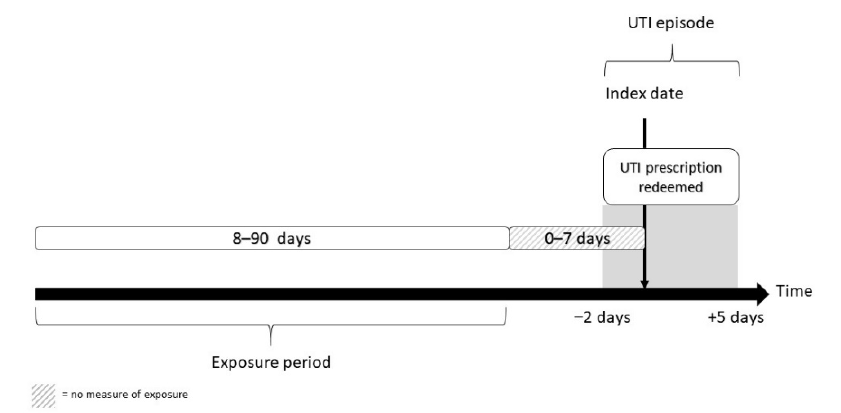
Figure 1. Inclusion of UTI episodes and ascertainment of